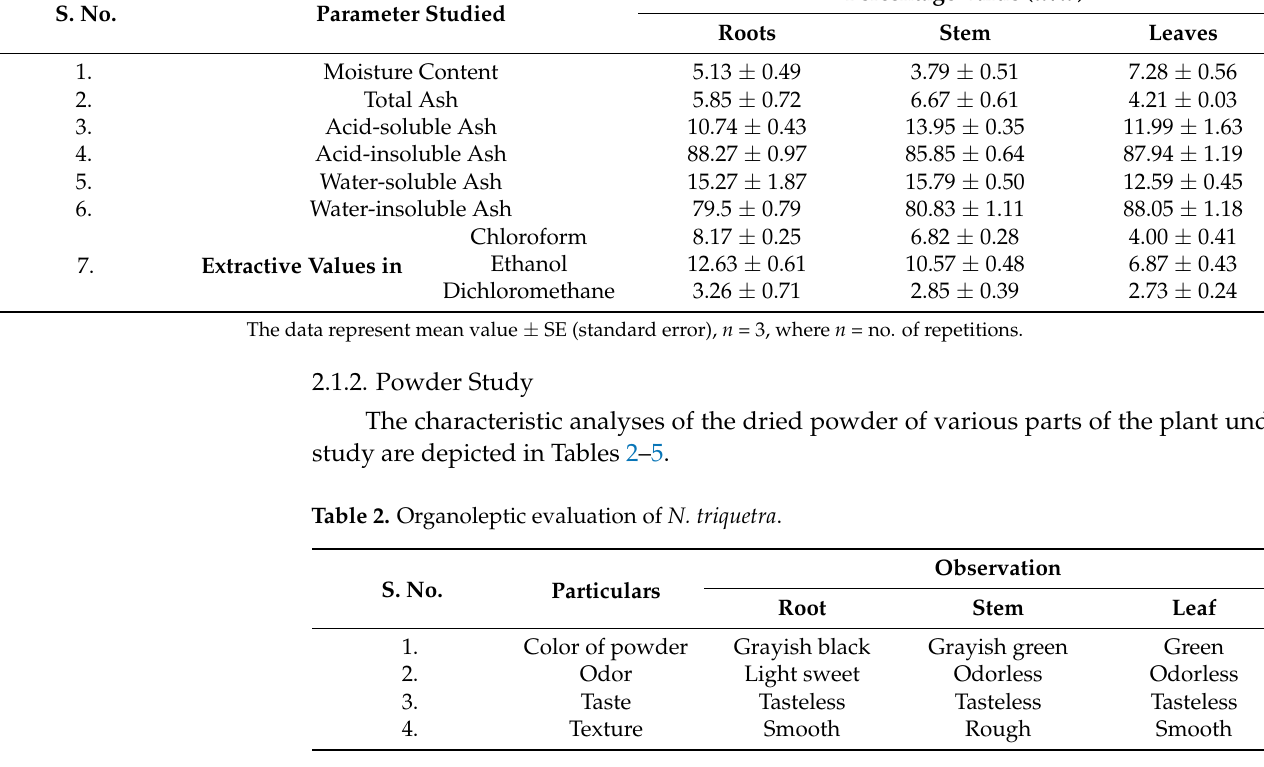
Table 3. Fluorescent behavior of N. triquetra root powder upon treatment with different chemical reagents. S. No.